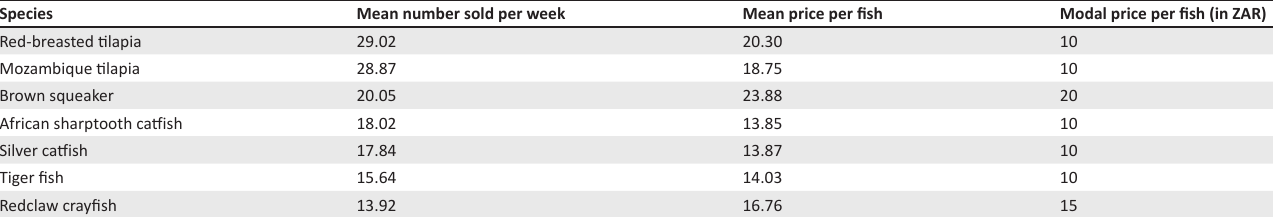
Redclaw crayfish ZAR, South African